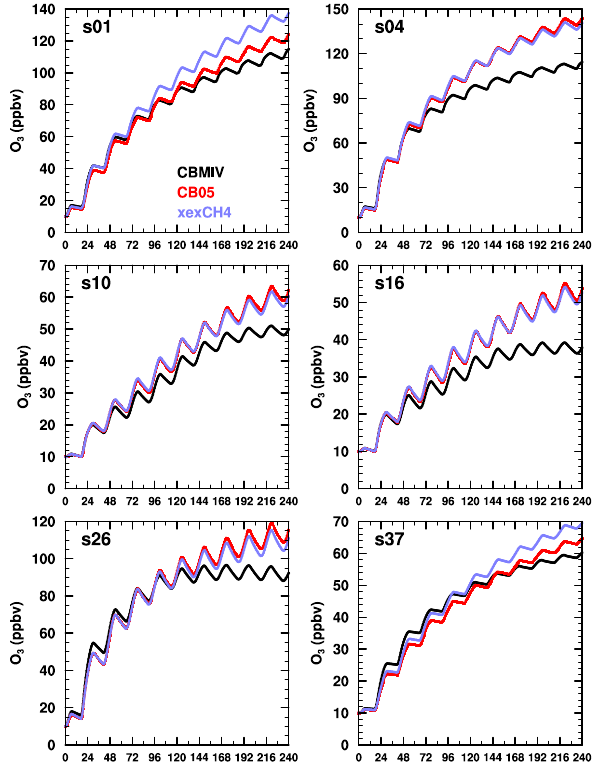
Fig. 4. Example scenario results for sensitivity test xexCH4. Ozone Figure 4 . Example scenario results for sensitivity test xexCH4 . Ozone mixing ratios (ppbv) 3 mixing ratios (ppbv) for the base CB05 (red), base CBMIV (black) for the base CB05 (red), base CBMIV (black) and sensitivity test xexCH4 (violet) over the 4 240 hr simulation period. 5 and sensitivity test xexCH4 (violet) over the 240h simulation pe- 6